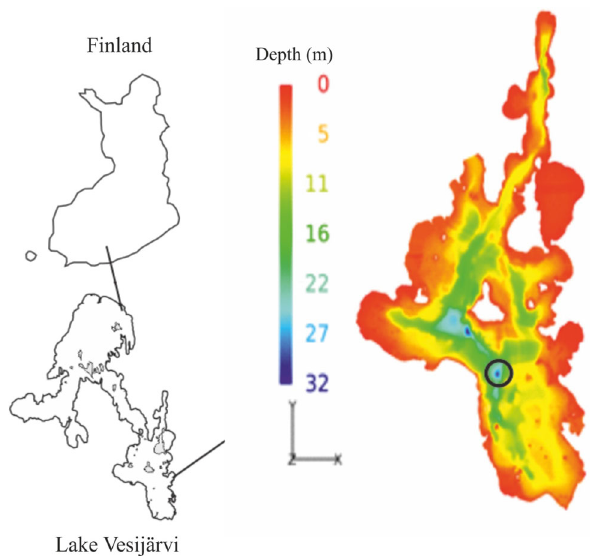
Fig. 1 Location of Lake Vesija¨rvi in Finland, and magnification and morphometry of the Enonselka¨ basin. The study station at the Lankiluoto deep is shown with a